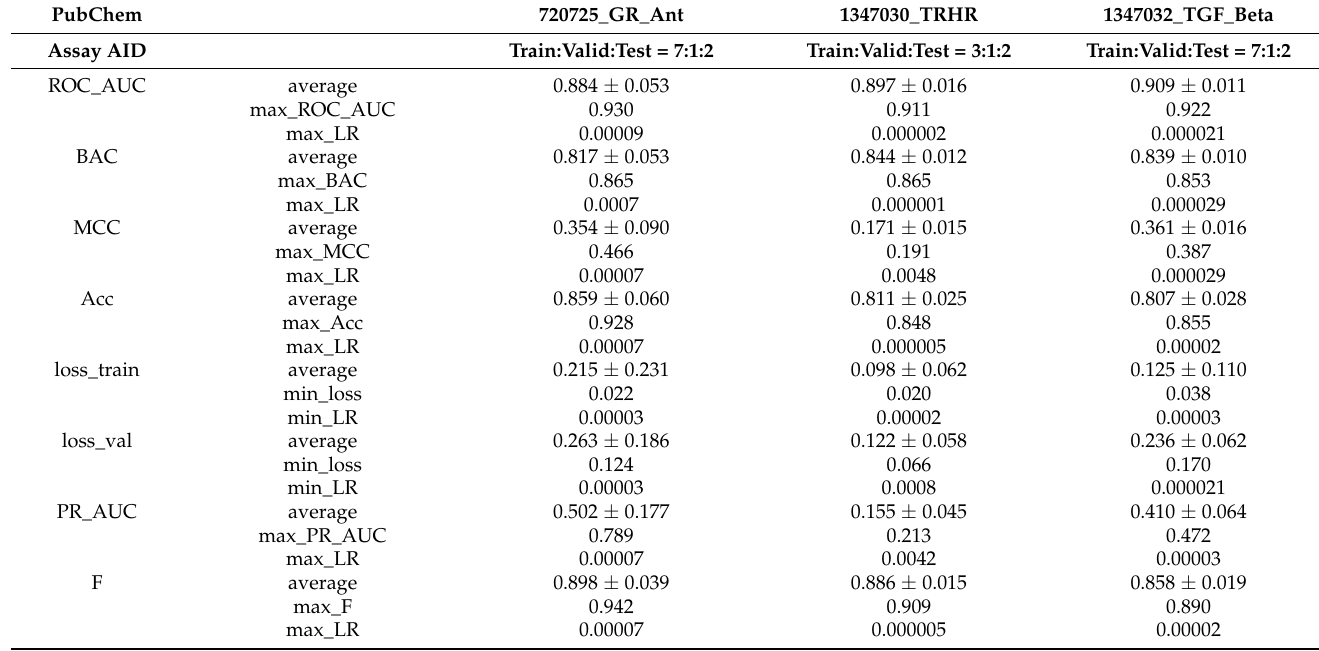
Table 4. Performances with LRs using DeepSnap_python system of the three MIE